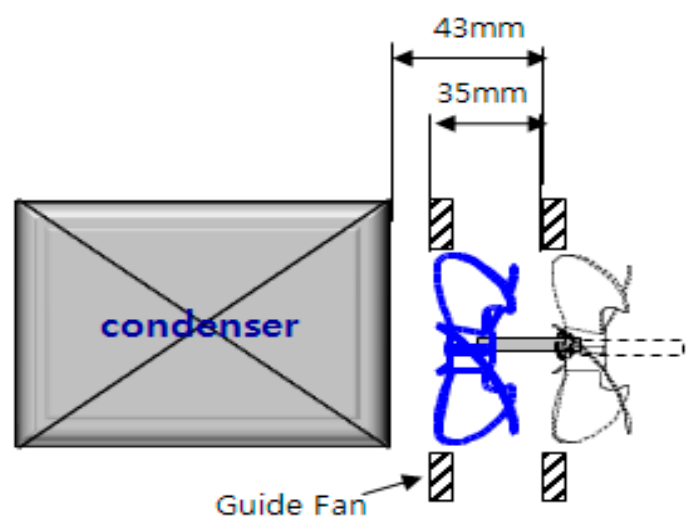
Figure 9. Displacement of the cooling fan position.